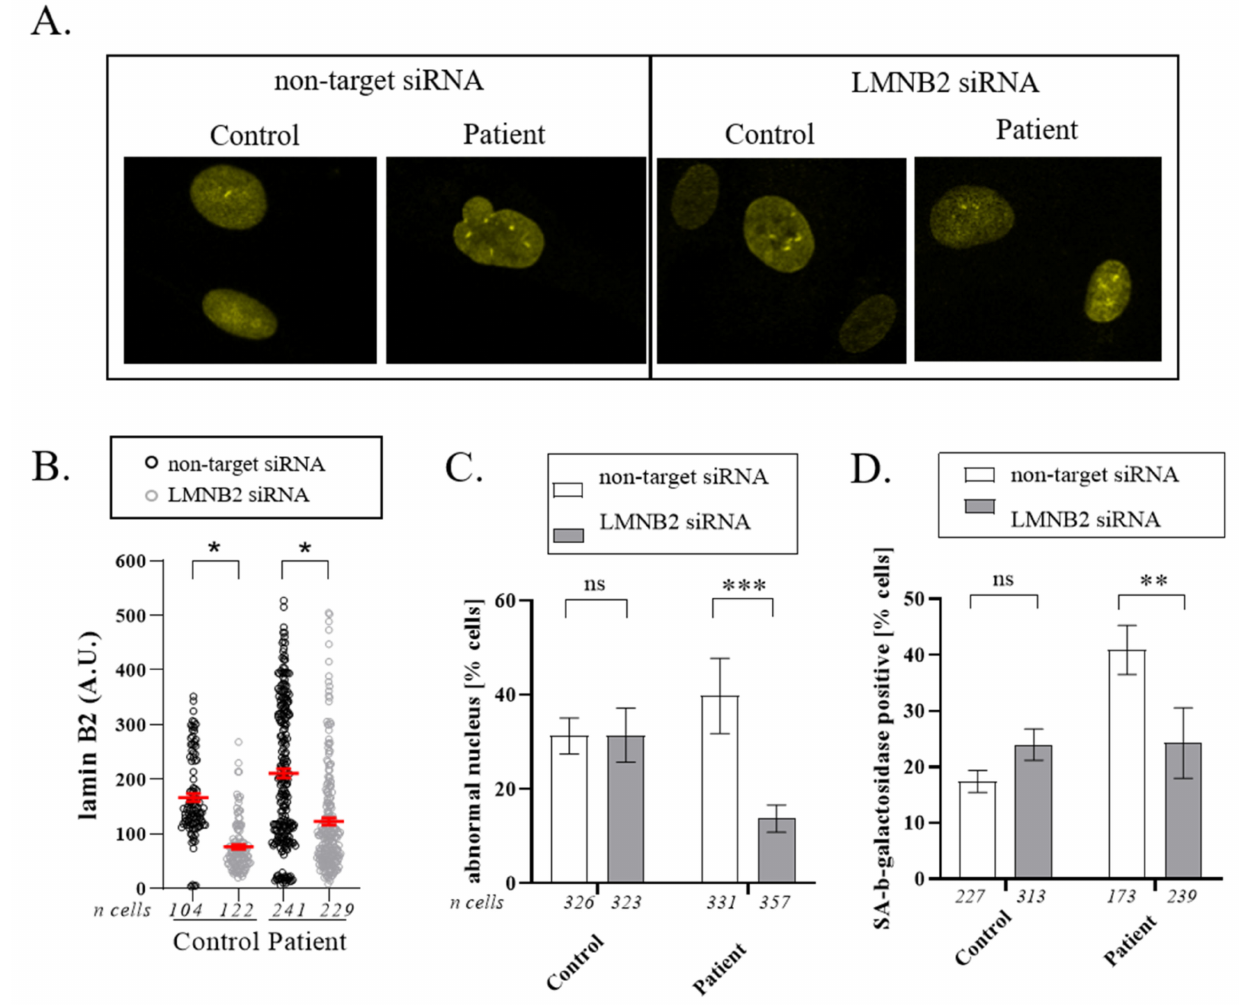
Figure 5. Decrease in lamin B2 expression leads to a decrease in nuclear abnormalities in patient cells. ( A ) Apotome images (objective 63 × ) showing the decrease in lamin B2 staining after transfection of siRNA targeting LMNB2 for both cell lines and decrease in nuclear abnormalities for patient cells. ( B ) The graph shows the mean intensity of lamin B2 (mean +/– SE from three independent experiments). Two-way ANOVA was performed on GraphPad, and a significant influence of the siRNA treatment on lamin B2 staining (*, p < 0.05, without difference between cell lines) was observed. ( C ) The graph depicts the percentage of cells with abnormally shaped nuclei (mean +/ − SE from three independent experiments). Two-way ANOVA was performed and measured a significant influence of the column factor (siRNA treatment) and of the interaction between row (cell lines) and column factor on the nuclear anomalies percentage (**, p < 0.01). A multiple comparison test showed a significant difference in the impact of the two different siRNAs on patient cells ( p = 0.0008) and not on control cells. ( D ) Percentage of SA-beta-galactosidase cells (mean +/ − SE from three independent experiments). Two-way ANOVA was performed and measured a significant influence of the row factor (cell line) and of the interaction between row (cell lines) and column factor (siRNA treatment) on the percentage of SA-beta-galactosidase cells (**, p < 0.01). A multiple comparison test showed a significant difference in the impact of the two different siRNAs on patient cells ( p = 0.0091) and not on control